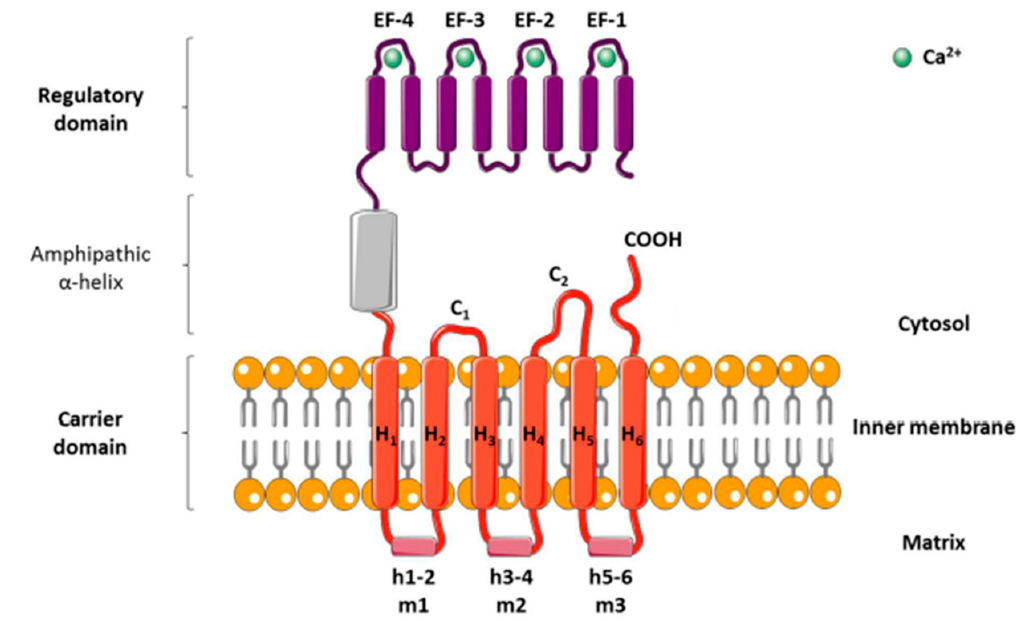
Figure 1. Structural model of the ADP / ATP carrier (AAC). The carrier consists of three separate domains: (1) an N -terminal regulatory domain with four calcium-binding EF-hands, (2) a loop domain containing an amphipathic α -helix, and (3) a mitochondrial ADP / ATP carrier. The carrier domain has six transmembrane helices (H1 to H6); three matrix loops (m1, m2, and m3), each containing a small hydrophilic helix (h1–2, h3–4, and h5–6); and two cytosolic loops (c1 and c2).